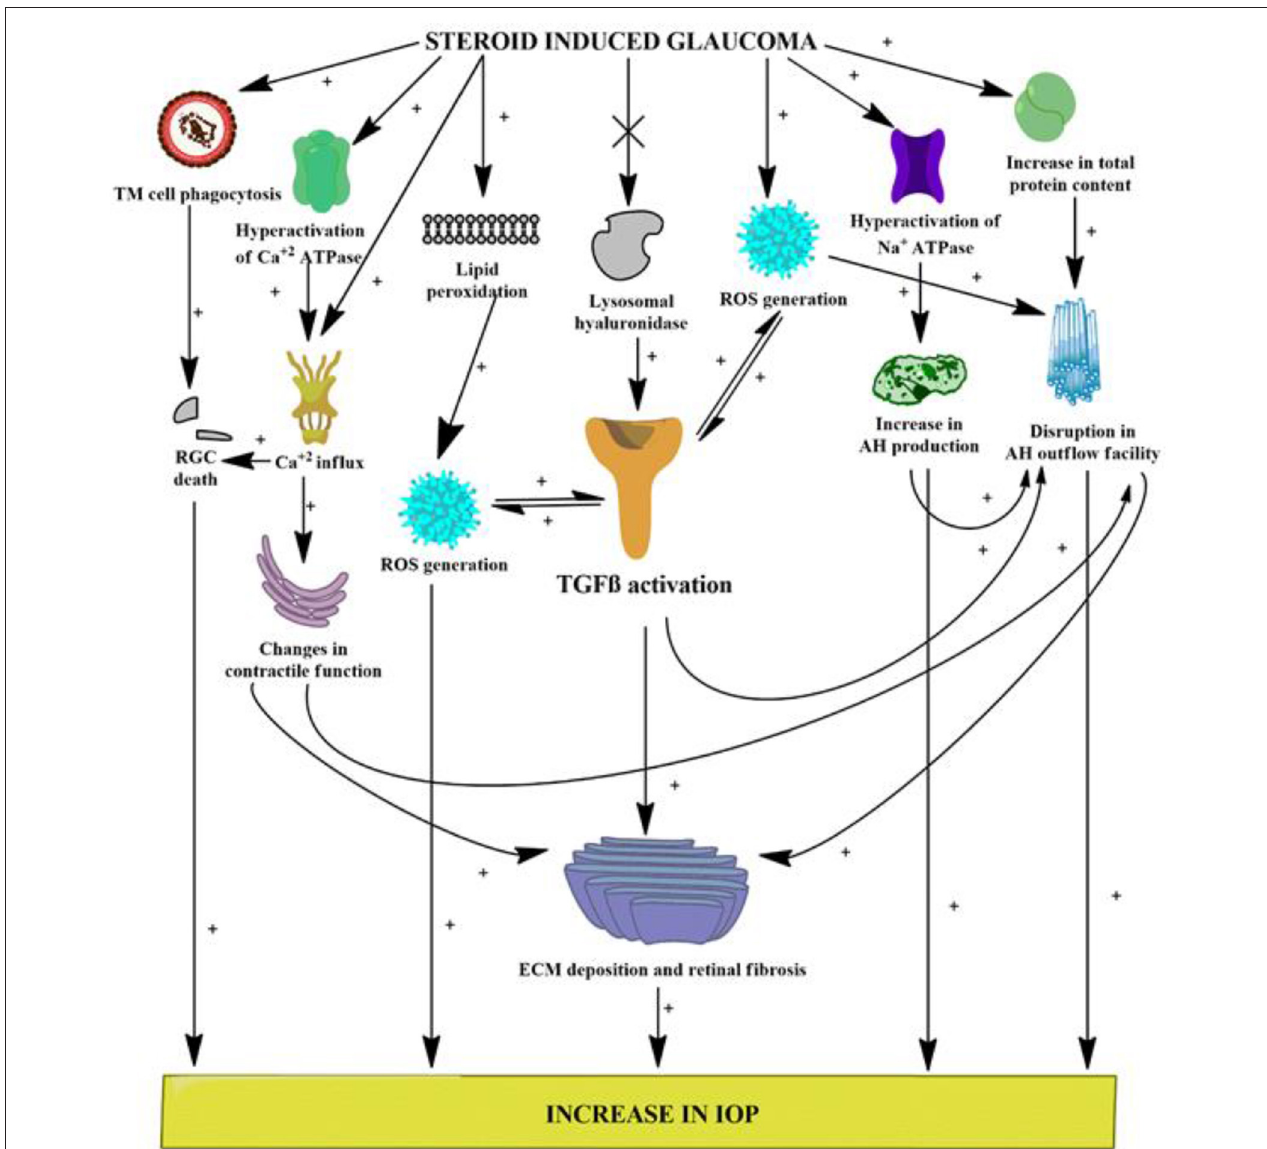
FIGURE 9 | Various possible targets served by DEX administration leading to glaucomatous conditions. [( + ) indicates activation or increase; (x) indicates inhibition or decrease]. ROS, reactive oxygen species; RGCs, retinal ganglion cells; AH, aqueous humor; IOP, intraocular pressure; TGF β , transforming growth factor β ; iNOS, inducible nitric oxide